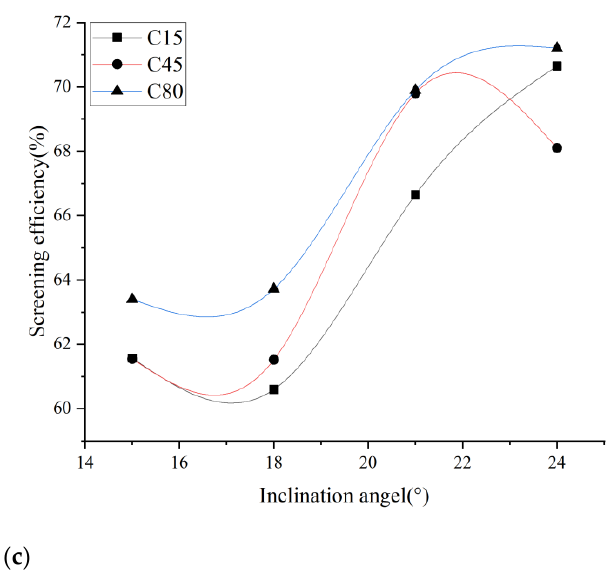
Figure 7. The effects of vibration parameters on the average screening efficiency. ( a ) the effects of amplitude on the average screening efficiency; ( b ) the effects of frequency on the average screening efficiency; ( c ) the effects of inclination angle on the average screening efficiency.